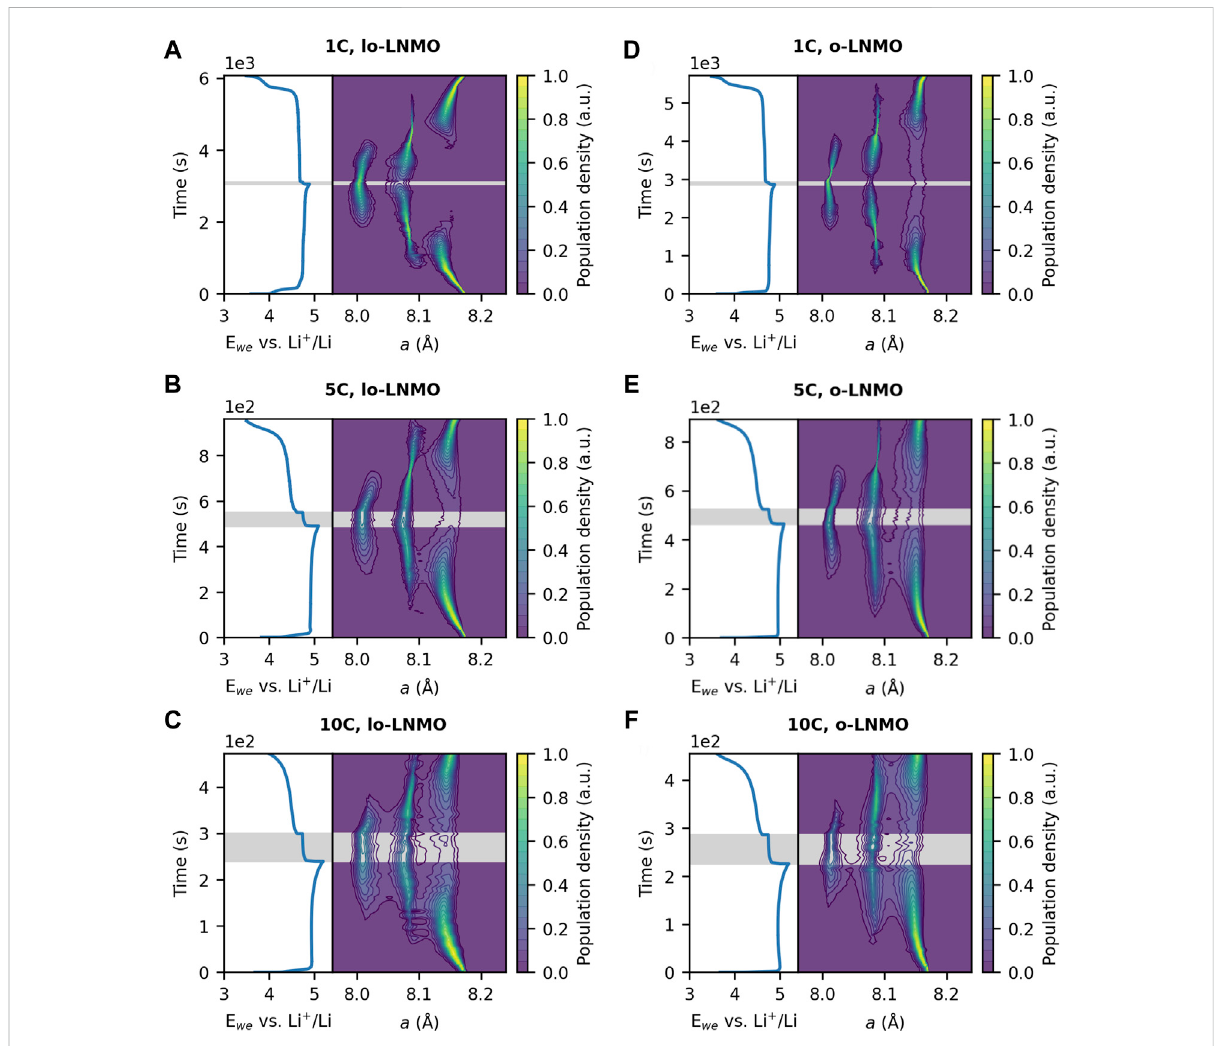
FIGURE 5 Distribution of the lattice parameter a during galvanostatic cycling at 1C, 5C and 10C, together with associated voltage pro fi les respectively, of (A – C) less ordered LNMO (lo-LNMO) and (D – F) ordered LNMO (o-LNMO). The lowest contour of the population density is drawn at a value of 0.05. The rest period at OCV is indicated by the shaded grey